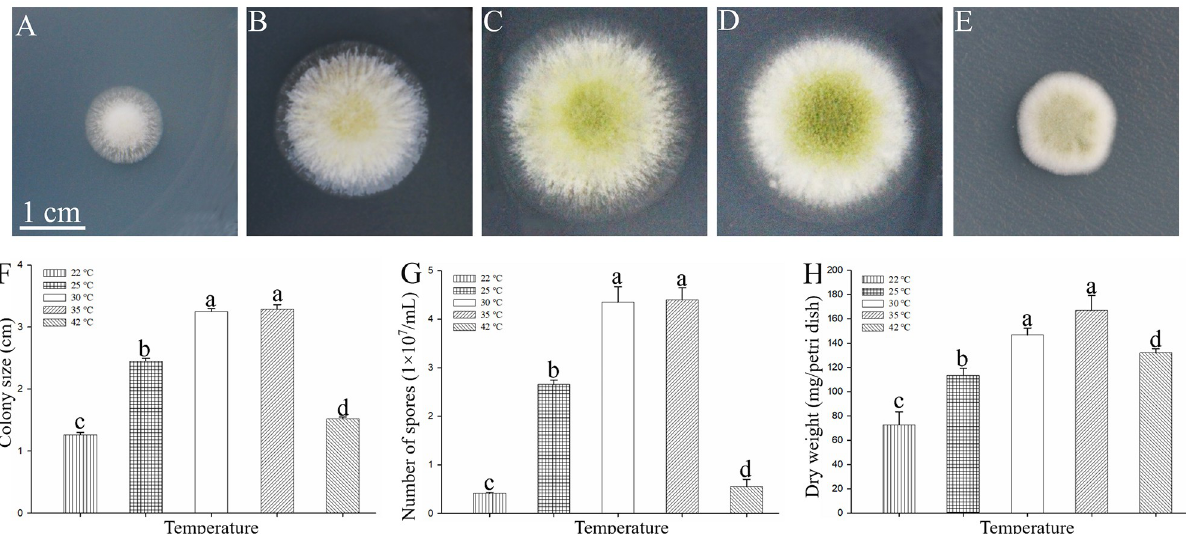
Fig 1. The hyphal growth and differentiation of A . oryzae under different temperatures for 72 h. (A-E) The phenotypes of A . oryzae on PDA media were incubated at different temperature, including 22, 25, 30, 35, and 42˚C for 72 h from left to right. (F) The colony sizes based on the diameter of the colonies. (G and H) The number of spores and dry biomass of A . oryzae mycelia under different temperature treatments. All values are mean ± SD of three replicates per treatment. The different lower-case letters indicate significant differences ( P < 0.05, n = 3), while the same letters indicate insignificant differences.